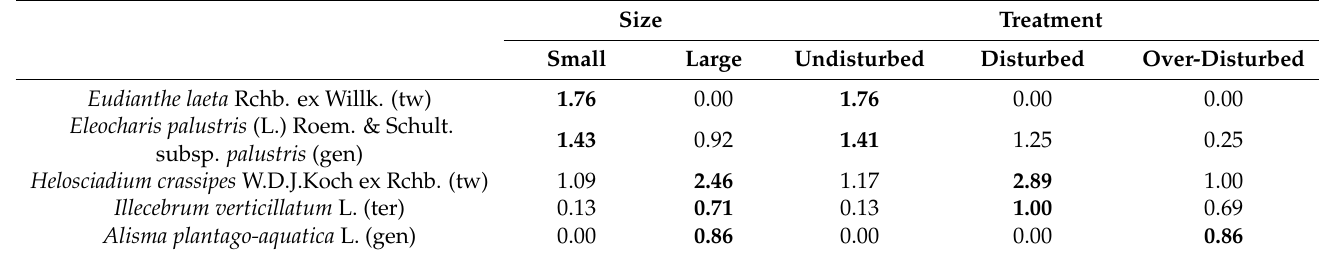
Table 1. Mean cover scores for the five discriminant taxa in groups of plots sorted by size and treatment. In bold, the highest values recorded for each plant species. Abbreviations: tw = specialist of temporary ponds, gen = generalist of wet habitats, ter = opportunistic terrestrial species. The complete list of mean cover values is reported in Table S2.